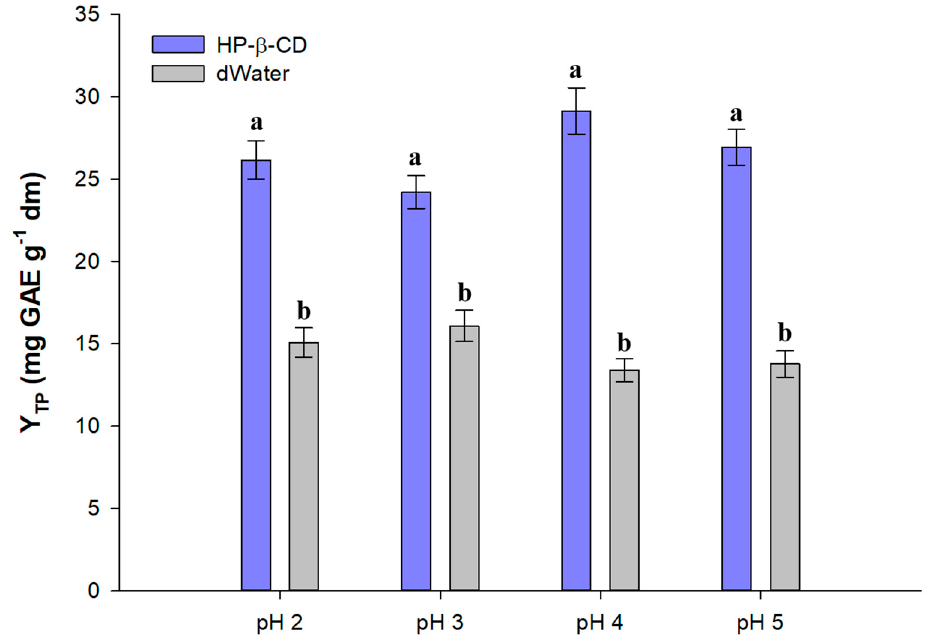
Figure 3. Effect of pH on the total polyphenol yield obtained with deionized water (dWater) and 15 mM hydroxypropyl- β -cyclodextrin (HP- β -CD) at 40 °C. Bars designated with different letters correspond to statistically different values ( p < 0.05).